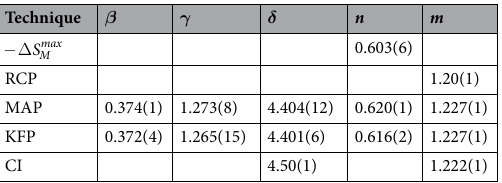
Table 1. Critical exponents of Fe 3 − x GeTe 214 . The MAP, KFP and CI represent the modified Arrott plot, the Kouvel-Fisher plot and the critical isotherm,